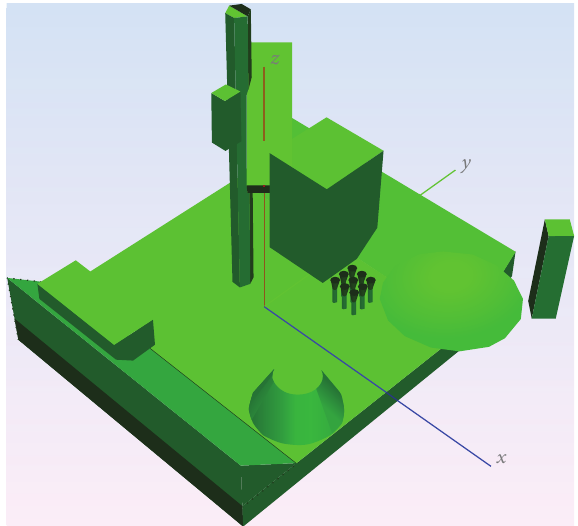
Figure 3: Geometrical model of Hispasat with an array of 3 × 3 conical horns.